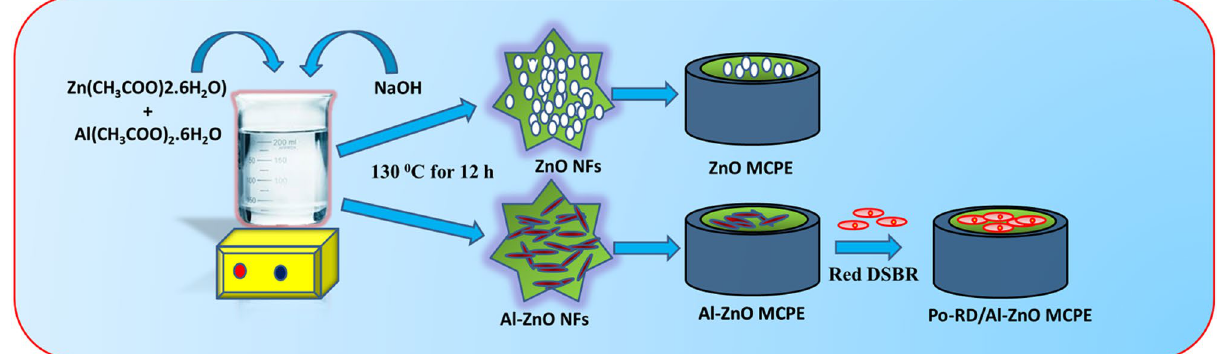
Figure 1. Schematic representation of the stepwise synthesis of NFs and fabrication of